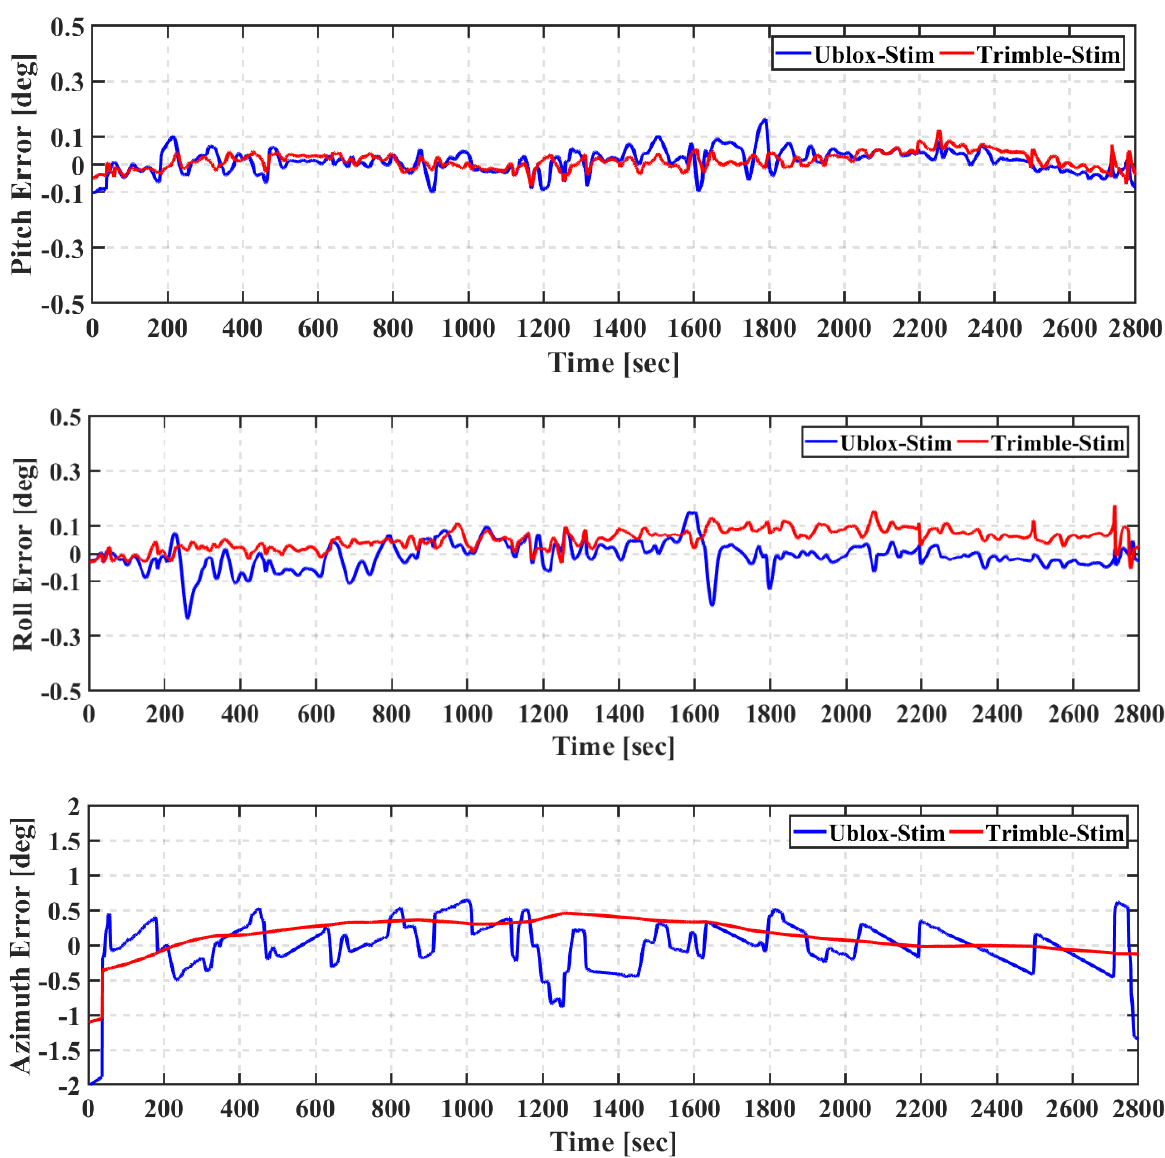
Figure 15. Second field trial: Pitch ( top ), roll ( middle ), and azimuth ( bottom ) of real-time TC GNSS PPP/INS for Ublox– Xsens and Trimble–Xsens solutions.